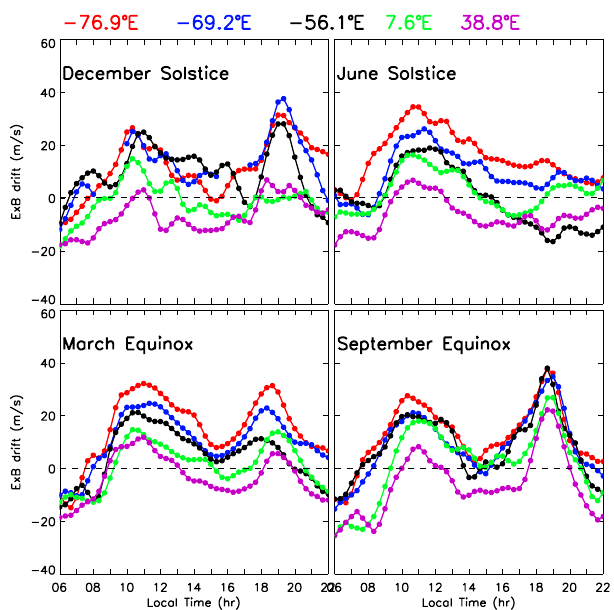
Fig. 5. Shows statistical temporal, longitudinal, and seasonal vari- ability of drift velocity measured by the IVM instrument onboard the C/NOFS satellite. Different colors represent different longitudi- nal sectors, which are given at the top.